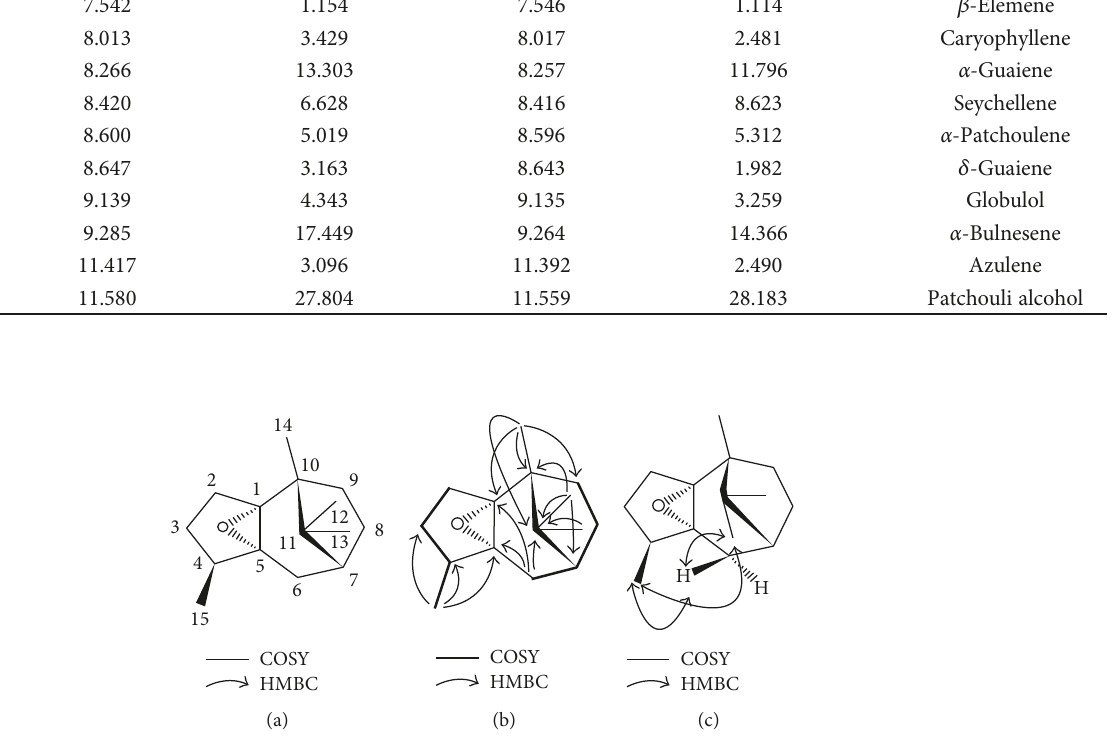
Figure 2: Identi fi cation of patchoulene epoxide (PAO). The chemical structure of PAO (a). Key 1 H- 1 H COSY and HMBC correlations of PAO (b). Key NOESY correlations of PAO (c).